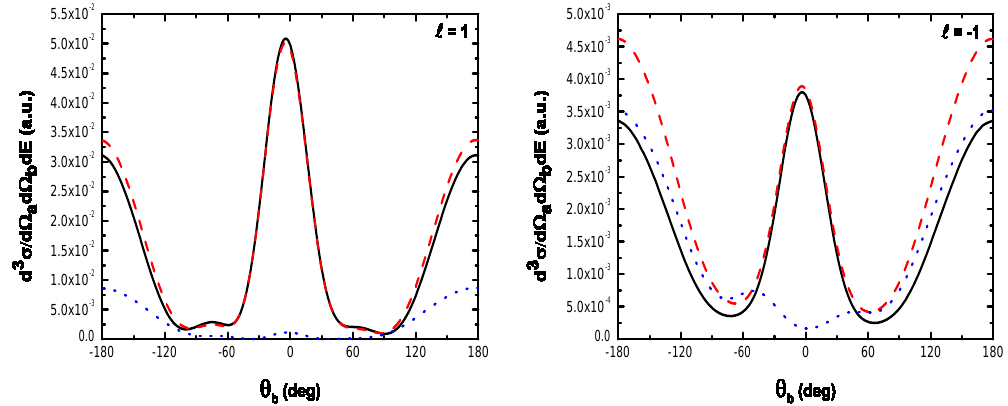
Figure 15. Same as Figure 14, but with the laser frequency ω = 2.34 eV.